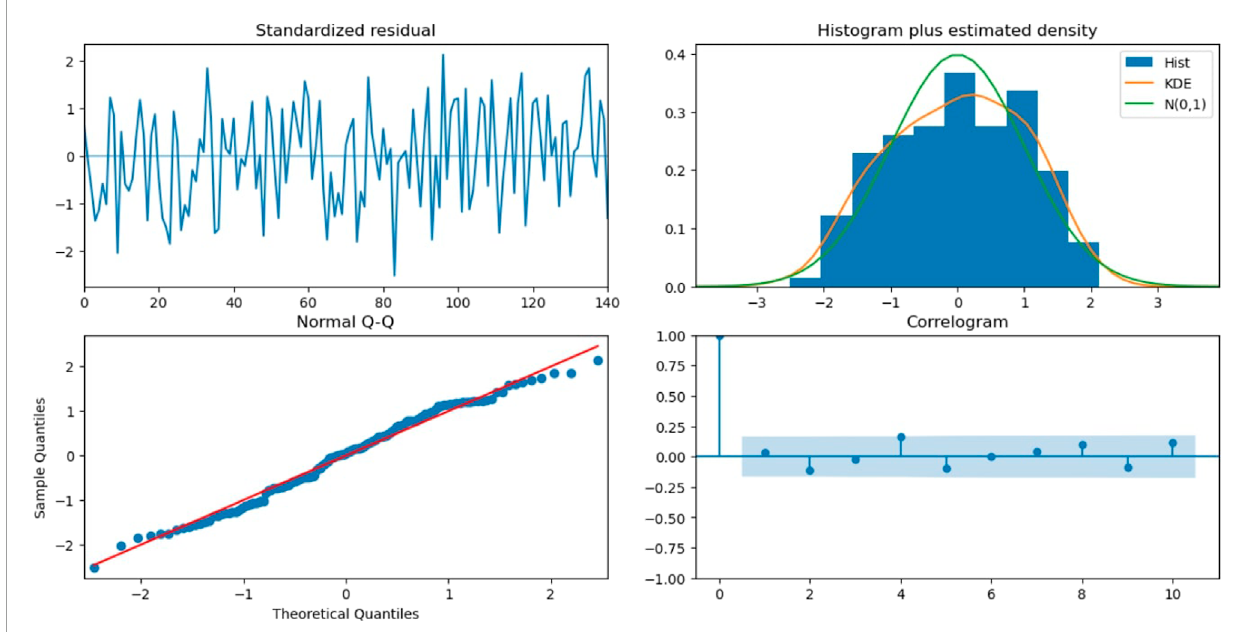
FIGURE 11 Diagnostics for the ARMA (1,1,1) model.